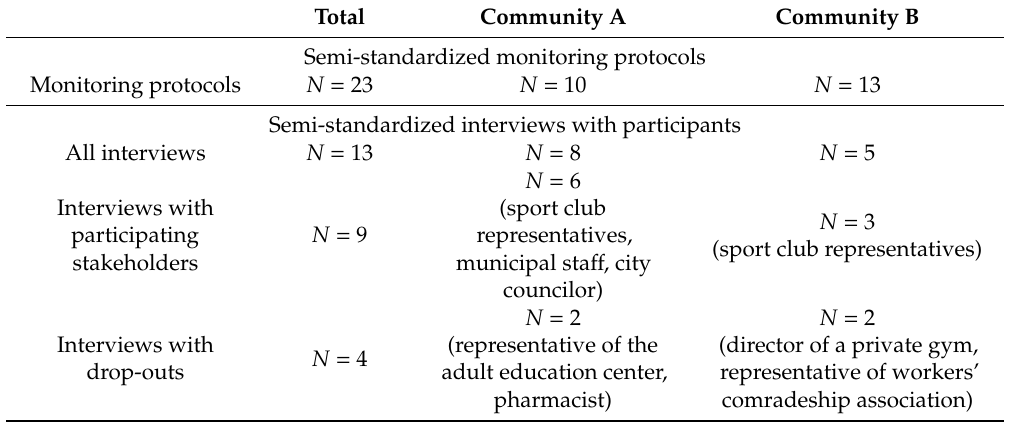
Table 2. Sample sizes for protocols and interviews retrieved from both